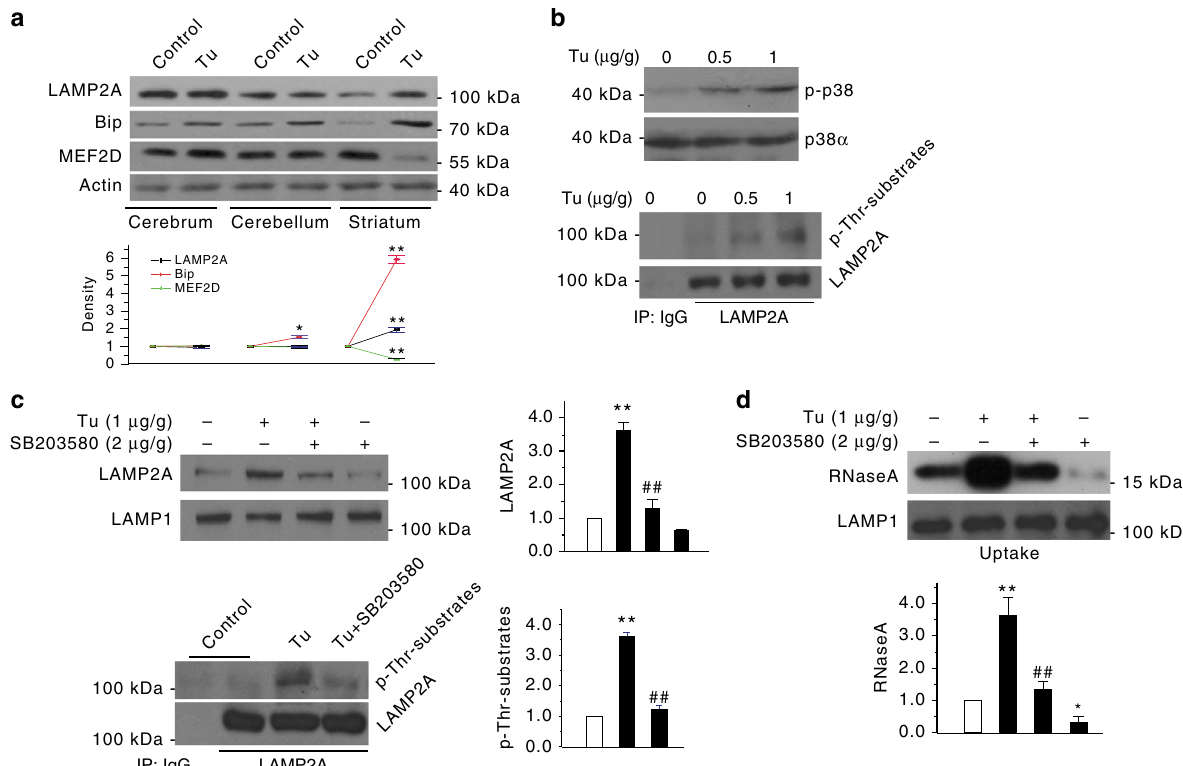
Fig. 8 ER stress induces CMA activation in vivo. a Tu induces ER stress in mouse brain. Mice were injected (i.p.) with Tu (1 μ g/g body weight), and then killed 2 days later for analysis ( n = 12). Levels of LAMP2A, Bip, and MEF2D in various brain regions of mice were determined by western blotting. b ER stress induces p-LAMP2A on striatal lysosomes in a p38 MAPK-dependent manner. Mice were treated with Tu (0.5 or 1 μ g/g body weight) alone or together with SB203580 for 24 h ( n = 9). Lysosomes isolated from striatal tissue were blotted for p-p38 MAPK (Left), and for IP with LAMP2A and IB with p-Thr-substrate antibody (Right and bottom). c , d ER stress increases both LAMP2A level and CMA activity of lysosomes isolated from the striatum. Mice were injected (i.p.) as described in ( a ) with or without co-injection of SB203580 and then killed after 24 h ( n = 9). Lysosomes isolated from the striatal tissue were analyzed for LAMP2A ( c ) or analyzed for CMA activity by uptake assay ( d ). Quanti fi cations are shown for a to d ( n = 6. All values are mean ± s.d. (unpaired two-tailed t test for LAMP2A/Bip/MEF2D, ANOVA with Turkey for others). * p < 0.05 or ** p < 0.005 vs. control and ## p < 0.005